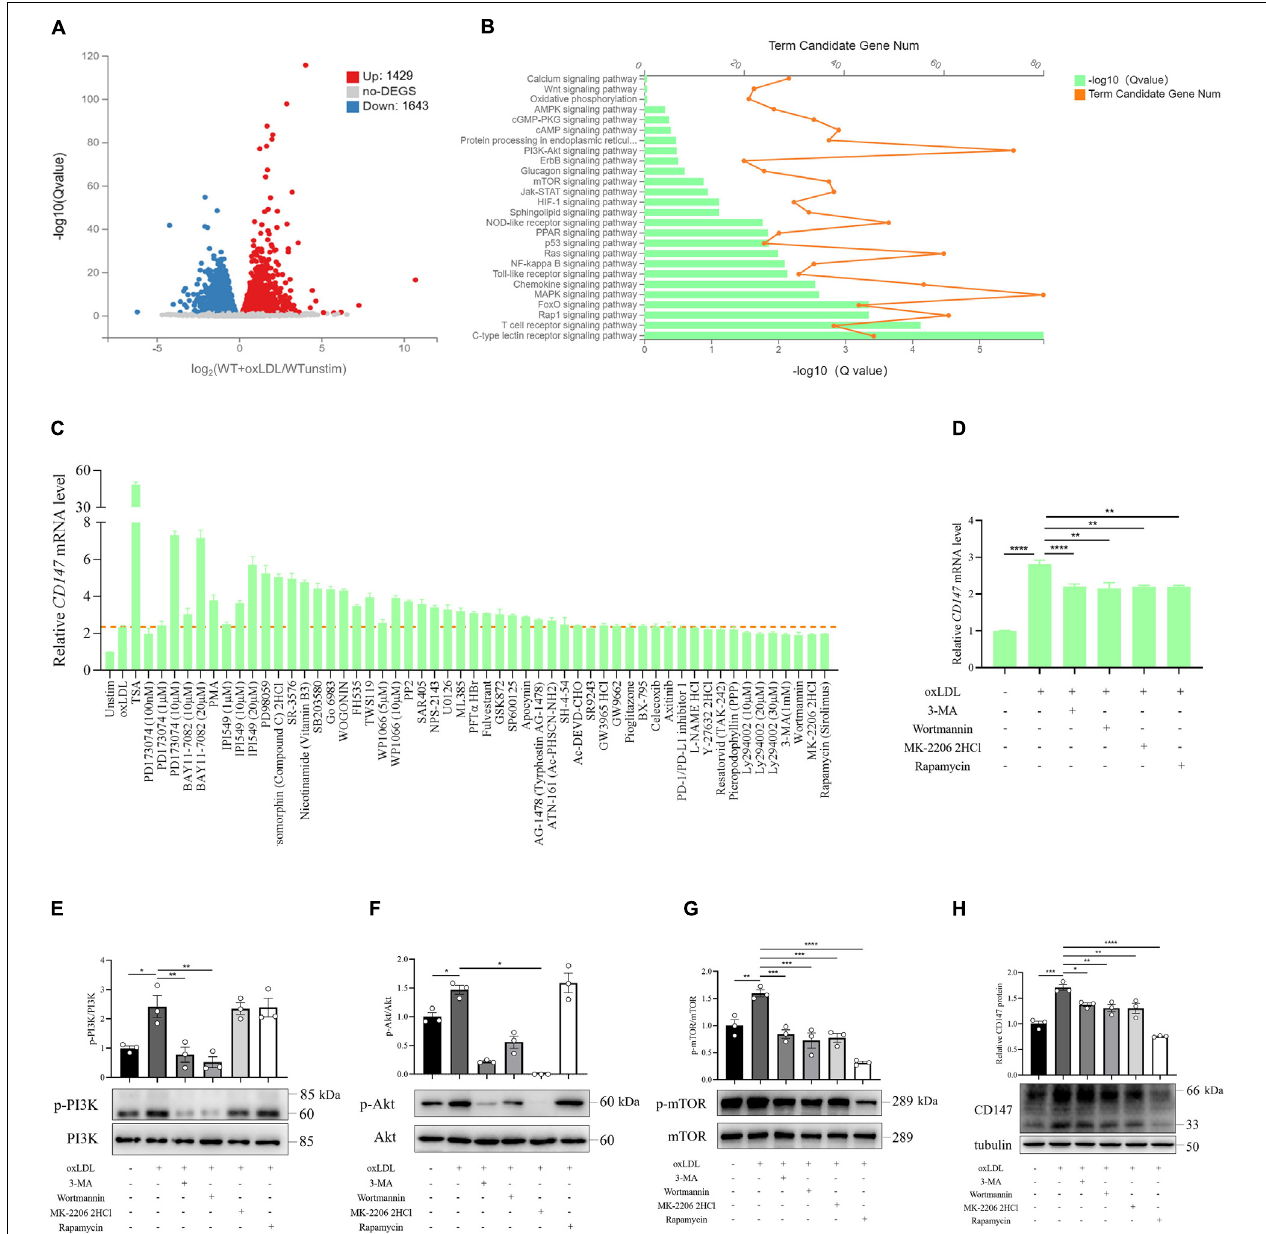
FIGURE 3 | Compound screening identifies PI3K/Akt/mTOR signaling as a regulator of CD147 expression induced by ox-LDL in macrophages. (A) WT BMDMs treated with or without ox-LDL (50 µ g/mL) for 24 h were analyzed by RNA sequencing. Identification of DEGs is illustrated in a volcano plot. (B) KEGG pathway enrichment histogram showing genes involved in foam cell formation based on the upregulated DEGs. (C) Overview of a large compound screening by RT-PCR showing CD147 mRNA levels in BMDMs incubated for 1 h with one of 46 potential compounds targeting 26 candidate signaling pathways and then treated with ox-LDL (50 µ g/mL) for 24 h. (D) RT-PCR analysis of CD147 mRNA levels in BMDMs treated with ox-LDL (50 µ g/mL) for 24 h in the presence or absence of 3-MA (1 mM), wortmannin (100 nM), MK-2206 2HCl (1 µ M), or Rapamycin (100 nM). (E–H) Western blot analysis of phosphorylated (p-) and total PI3K, Akt, and mTOR and CD147 in BMDMs exposed to 50 µ g/mL ox-LDL for 24 h in the presence or absence of 3-MA (1 mM), wortmannin (100 nM), MK-2206 2HCl (1 µ M), or Rapamycin (100 nM). Data represent the mean ± SEM. of n ≥ 3 biologically independent experiments. * P < 0.05, ** P < 0.01, *** P < 0.001, **** P < 0.0001.